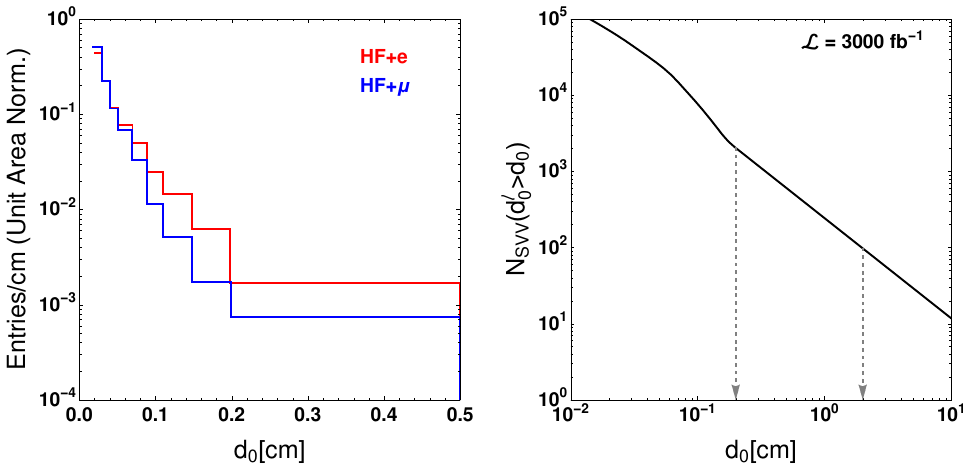
Figure 5 . Left panel : the normalized d 0 distribution for HF+ e and HF+ (cid:22) control regions from ref. [58]. Right panel : the total number of SM background after applying minimal d 0 cut with all the trigger and selection cuts applied, denoted as N SVV arrow indicates two of our benchmark minimal d 0 cuts of 0.2 cm and 2 cm